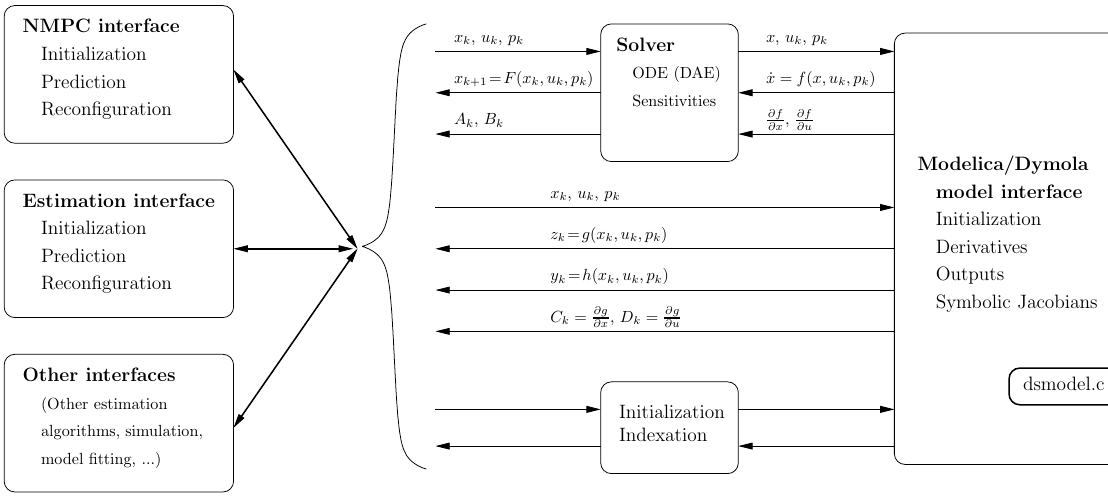
Figure 2: Overview over model component data